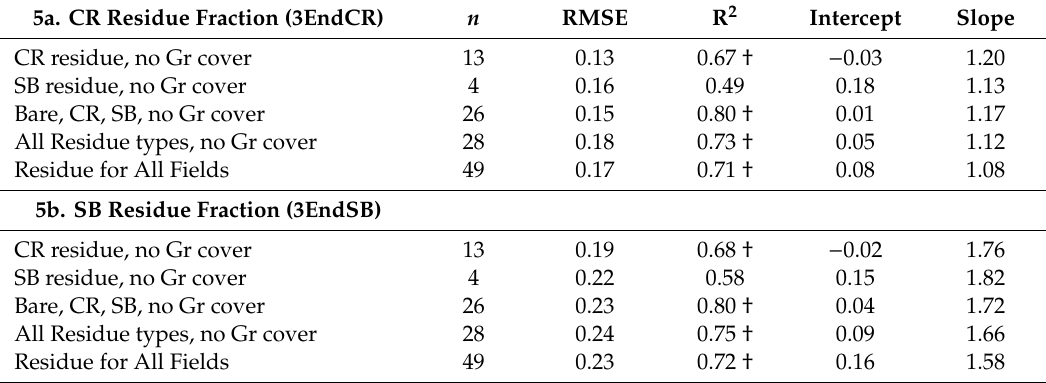
Table 5. Comparison between subsets of field residue cover measurements (x) and unmixed